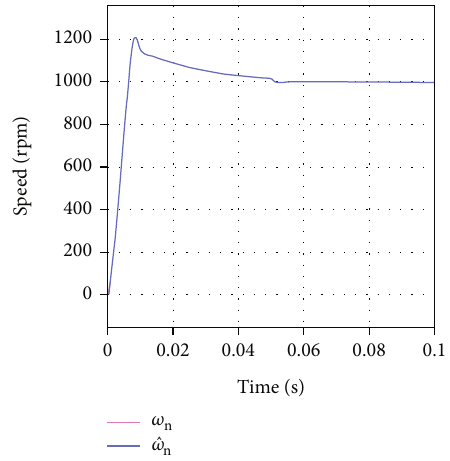
Figure 22: Estimated speed and actual speed for 2021 LO.